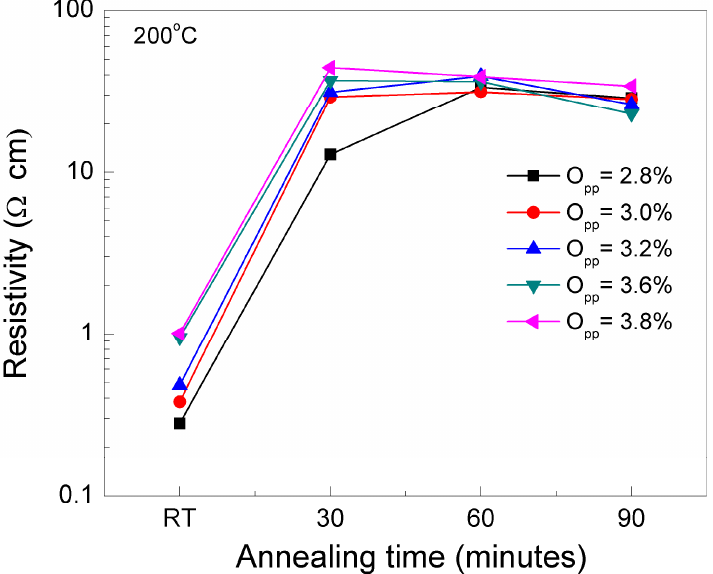
Figure 2. Resistivity of SnO x films as a function of annealing time, for films processed at different O pp, as depicted in the Figure .